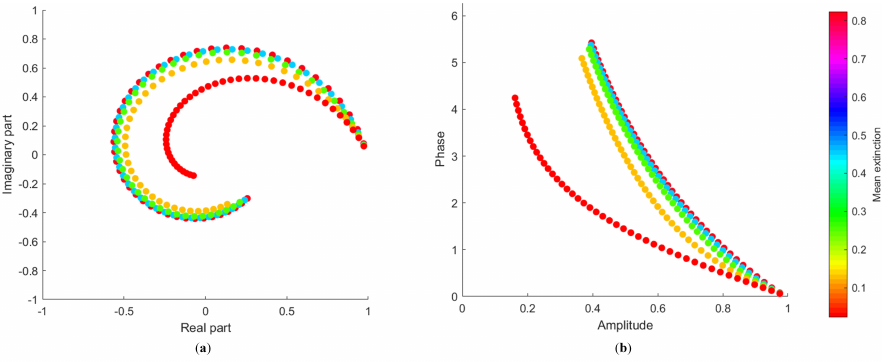
Figure 5. The LUTs in different planes: ( a ) the CUC plane and ( b ) the amplitude-phase plane.